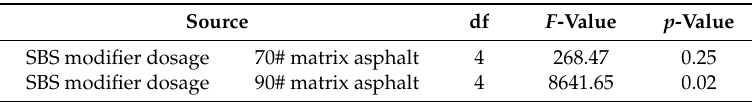
Table 4. Variance analysis of softening point for SBS modified asphalt.